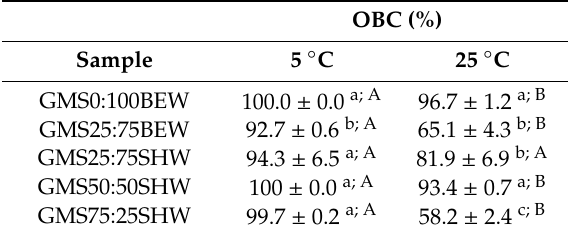
Table 3. Oil binding capacity of mono and multicomponent wax-based